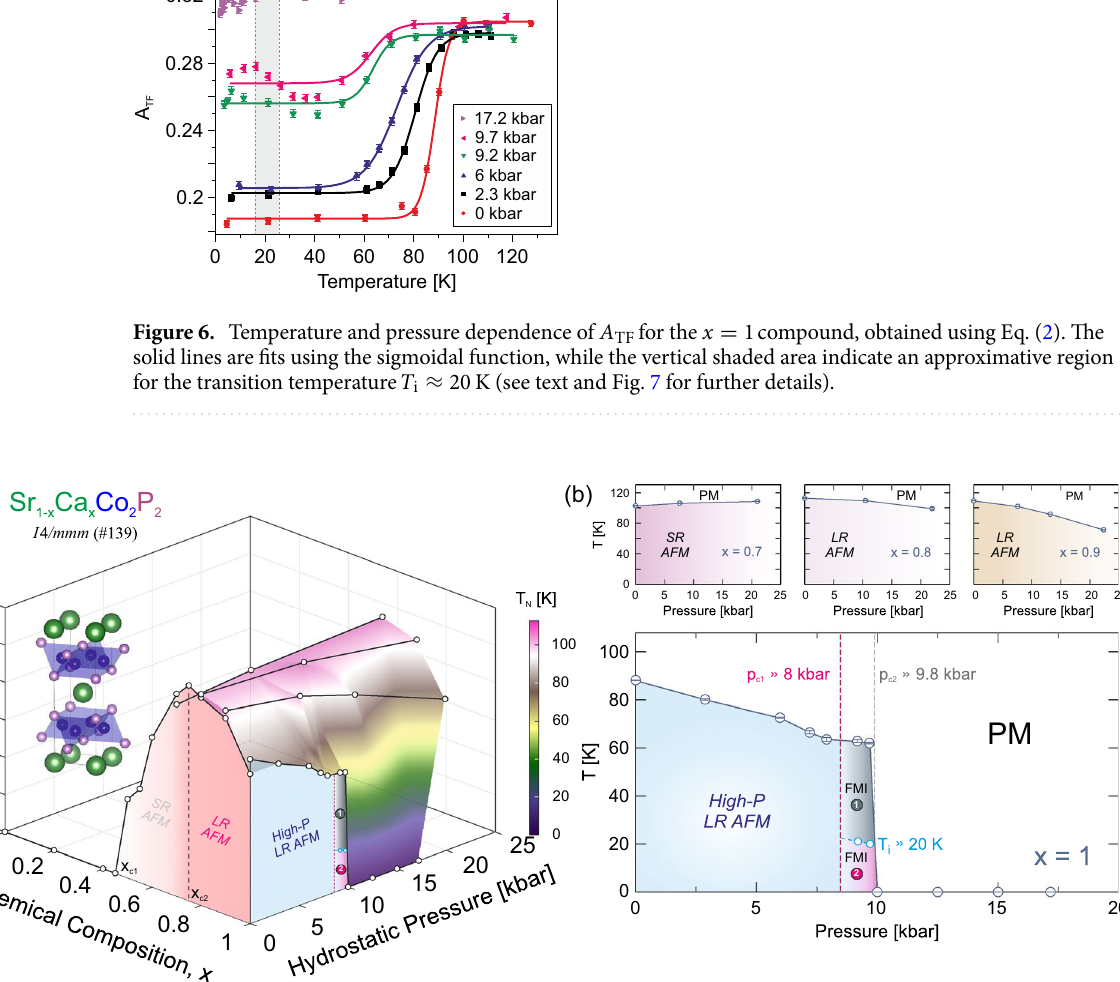
Figure 7. ( a ) Phase-diagram ( p / T / x ) for Sr 1 − x Ca x Co 2 P 2 . ( b ) Individual p / T phase diagrams for different chemical compositions ( x ). Phases are labelled: SR short-range, LR long-range, AFM antiferromagnetic, FMI ferromagnetic islands, PM paramagnetic. Further, p c1 ≈ 8 kbar and p c2 ≈ 9.8 kbar are the critical pressures and x c1 ≈ 0.45 and x c2 ≈ 0.75 critical chemical compositions 11 . Finally, T i ≈ 20 K is an approximate transition temperature between the FMI- 1 (cid:31) and FMI- 2 (cid:31)